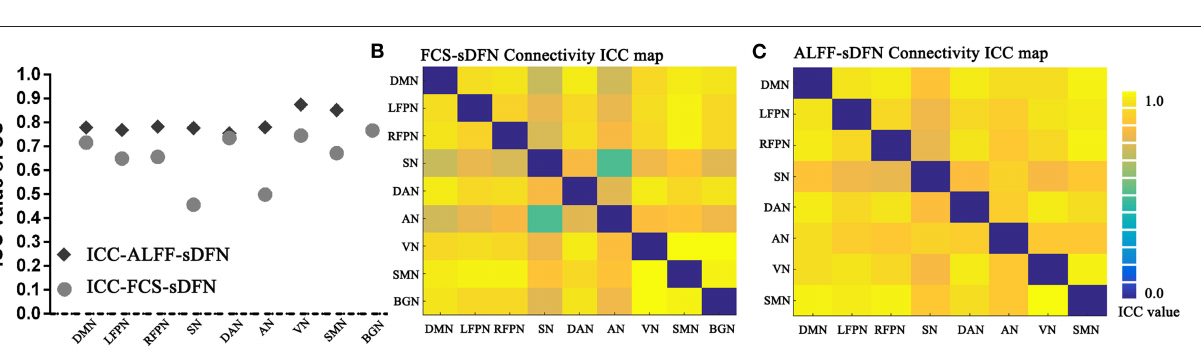
FIGURE 5 | Relationship between clinical symptoms of schizophrenic subjects and dynamic functional connectivity (dFC) within the spatial organization of dynamic functional network (sDFN), and connectivity between sDFNs respectively. (A1) Denotes a negative relationship between the dynamic FCS value of right insula (Ins) within SN-sDFN and p-PANSS scores. (A2) Denotes the negative relationship between total score of PANSS and connectivity between ALFF-sDFN (SN and RFPN). FCS, functional connectivity strength; ALFF, amplitude of low-frequency fluctuations; PANSS, Positive and Negative Symptom Scale.